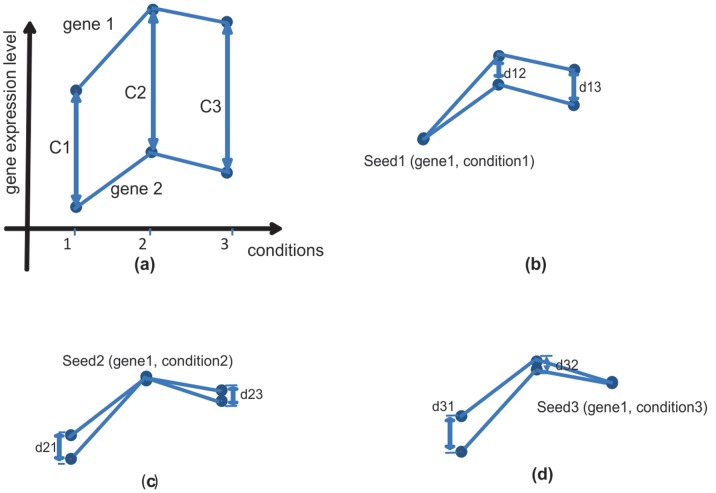
An example of finding suitable constant C that satisfies Eq (1).(a) Both gene1 and gene2 are measured by their expressed levels on three conditions. The distances between gene1 and gene2 on conditions 1, 2, and 3 are represented by C1, C2, and C3 respectively. (b) d12 and d13 are the distances between gene1 and gene2 on conditions 2 and 3 in terms of seed1. (c) and (d) show the distances of the two genes in term of seed2 and seed3.